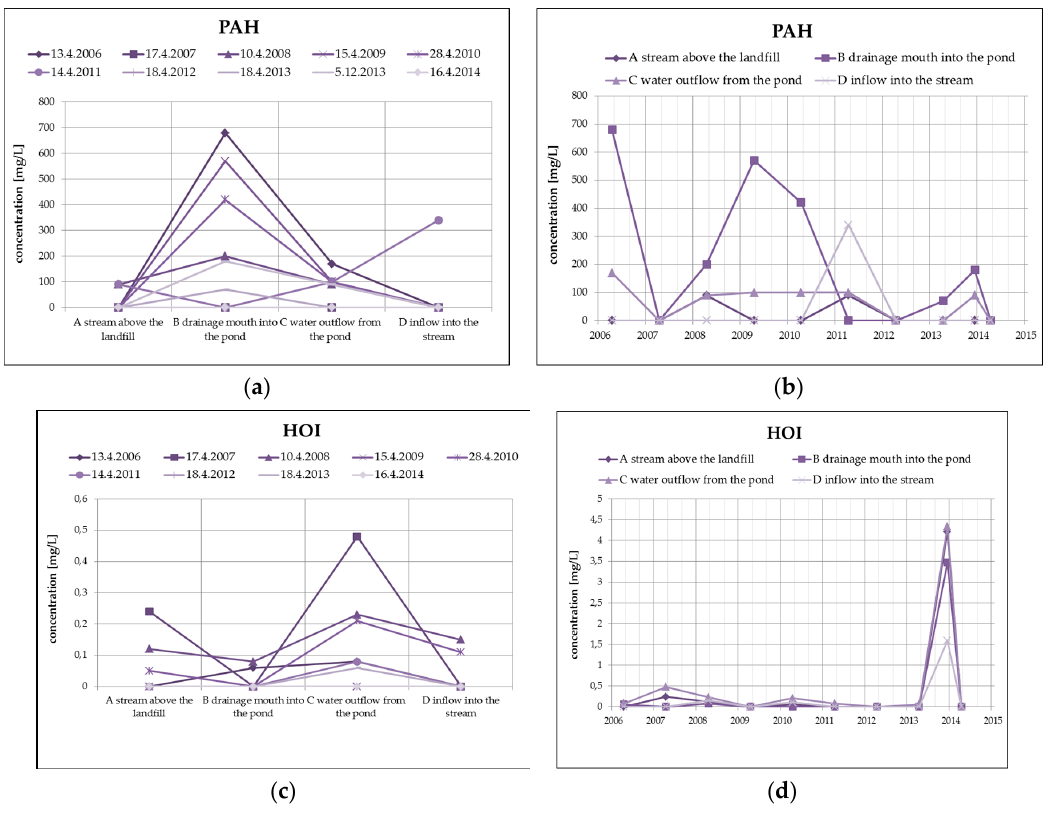
Figure 8. Change of PAH values in surface water depending on the monitored profile ( a ) and time ( b ) and change of HOI values in surface water depending on the monitored profile ( c ) and time ( d ).